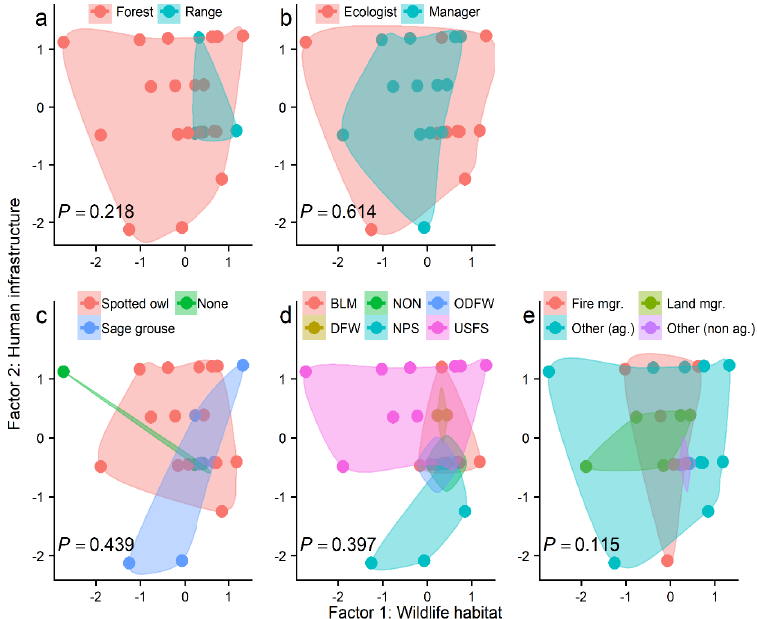
Figure 3. Plots of the respondents’ factor scores grouped by ( a ) ecosystem type, ( b ) occupational category, ( c ) refugia species of concern, ( d ) agency, and ( e ) management type. Polygons were plotted to encircle all points within each group. Agencies are: US Forest Service (USFS), US Bureau of Land Management (BLM), Washington Department of Fish and Wildlife (DFW), National Park Service (NPS), Oregon Department of Fish and Wildlife (ODFW), and all others (NON). Occupations are “Fire mgr.” (fire manager), “Land mgr.” (land manager), “Other (ag.)” (other agency positions), and “Other (non ag.)” (other non-agency positions). p -values are from MANOVA tests, which test for di ff erences between groups by respondent’s